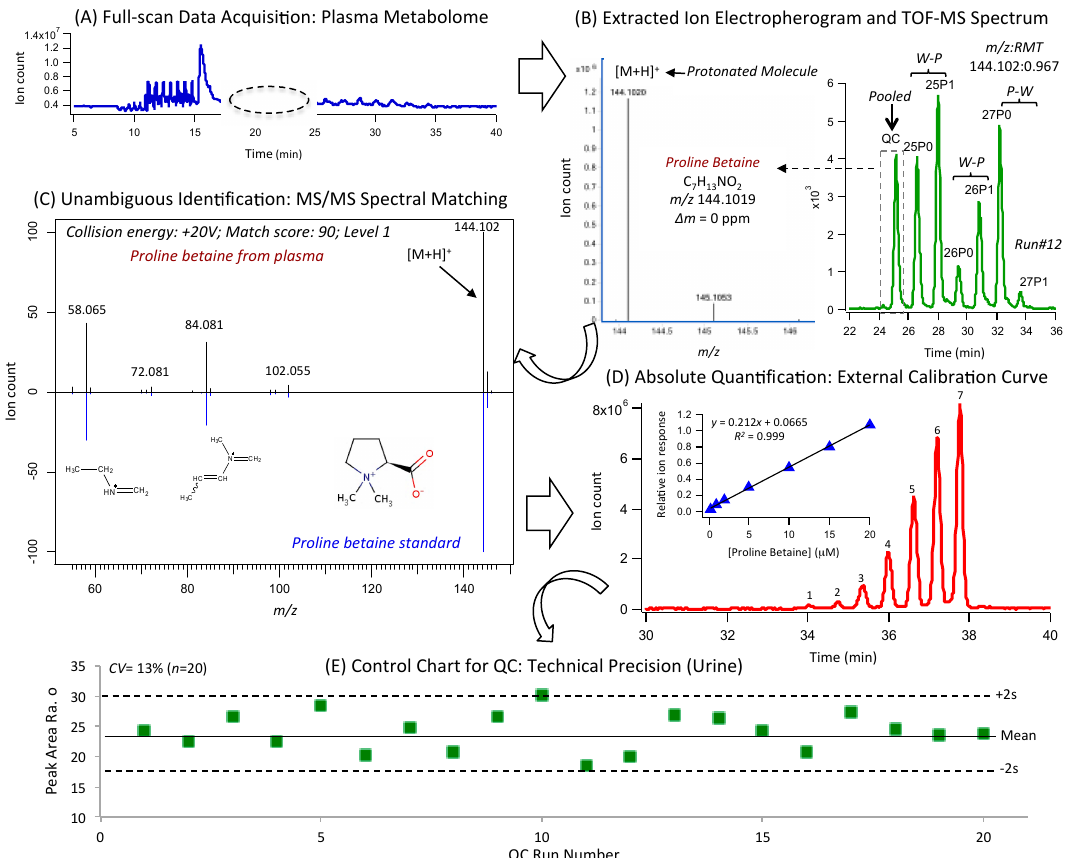
Figure 2. Summary of the metabolomics data workflow in MSI-CE-MS for the identification and quantification of biomarkers associated with a Prudent or Western diet. ( A ) A total ion electropherogram for plasma is shown with full-scan data acquisition under positive ion mode, whereas ( B ) an extracted ion electropherogram for an authentic unknown cation ( i.e., [M+H] + ) is annotated by its m/z :RMT based on serial injection of seven plasma samples within a single run. Each run is comprised three pairs of samples collected from DIGEST participants ( i.e., baseline diet, and two weeks after food provisions) together with a QC for assessing technical precision, and correcting long-term signal drift. High-resolution MS spectra allows for determination of the most likely molecular formula, and ( C ) MS/MS spectra enable structural elucidation of the ion when compared to an authentic standard for ProBet. ( D ) Quantification of ProBet is performed by external calibration when using an internal standard (Cl-Tyr) for data normalization by MSI-CE-MS. ( E ) A control chart for ProBet from repeated measurements of QC samples in every MSI-CE-MS run demonstrates acceptable technical precision (CV = 13%, n = 20) over 3 days of analysis. Table 1. Major changes in dietary patterns following two weeks of a Prudent or Western diet relative to baseline habitual diet of DIGEST participants ( n = 42) based on self-reported diet records. Diet Category a W-P, n = 24 P-W, n = 18 p for Comparison/Outcome b